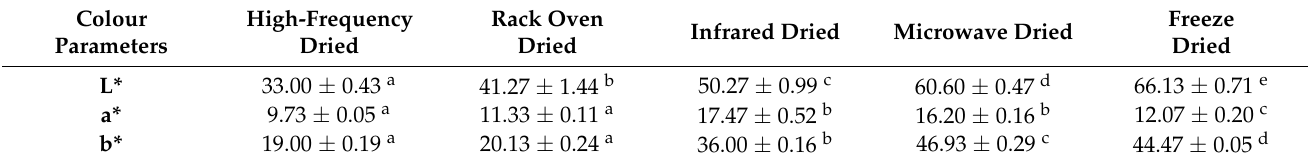
Table 3. Colour parameters of dried mealworm